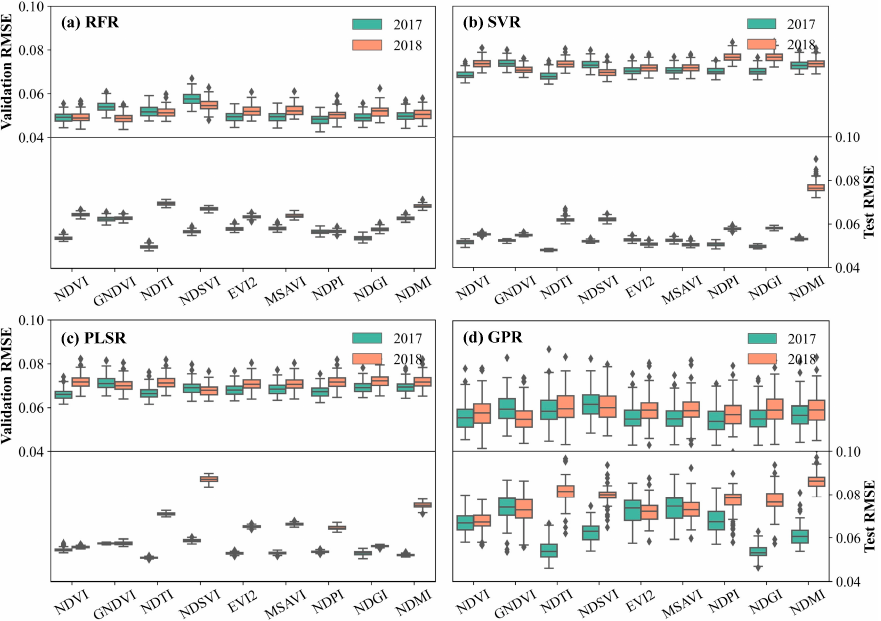
Figure 5. Validation accuracy and test accuracy of RFR ( a ), SVR ( b ), PLSR ( c ), and GPR ( d ) methods in the West subregion. Diamonds are outliers beyond the upper and lower quartiles by 1.5 times the interquartile range.